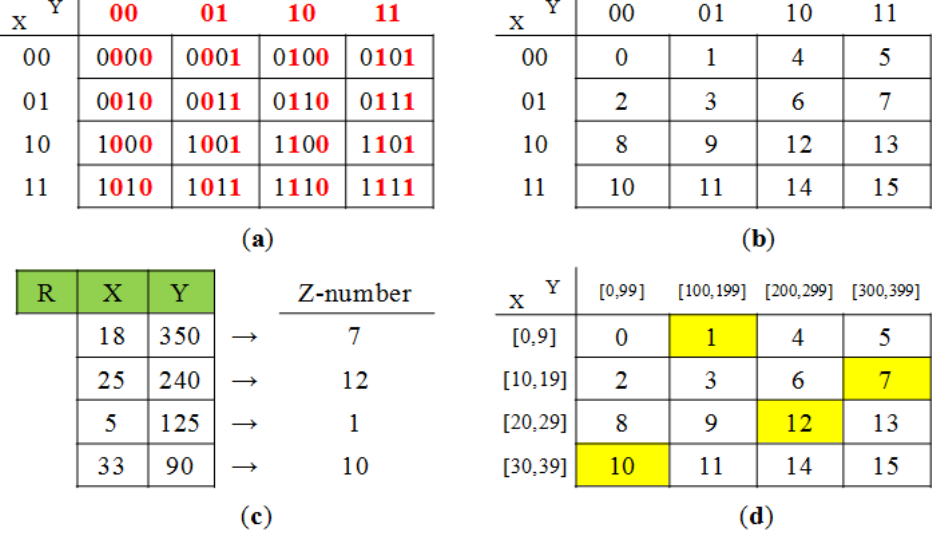
Figure 10. Z-ordering and its application for encoding joining attribute